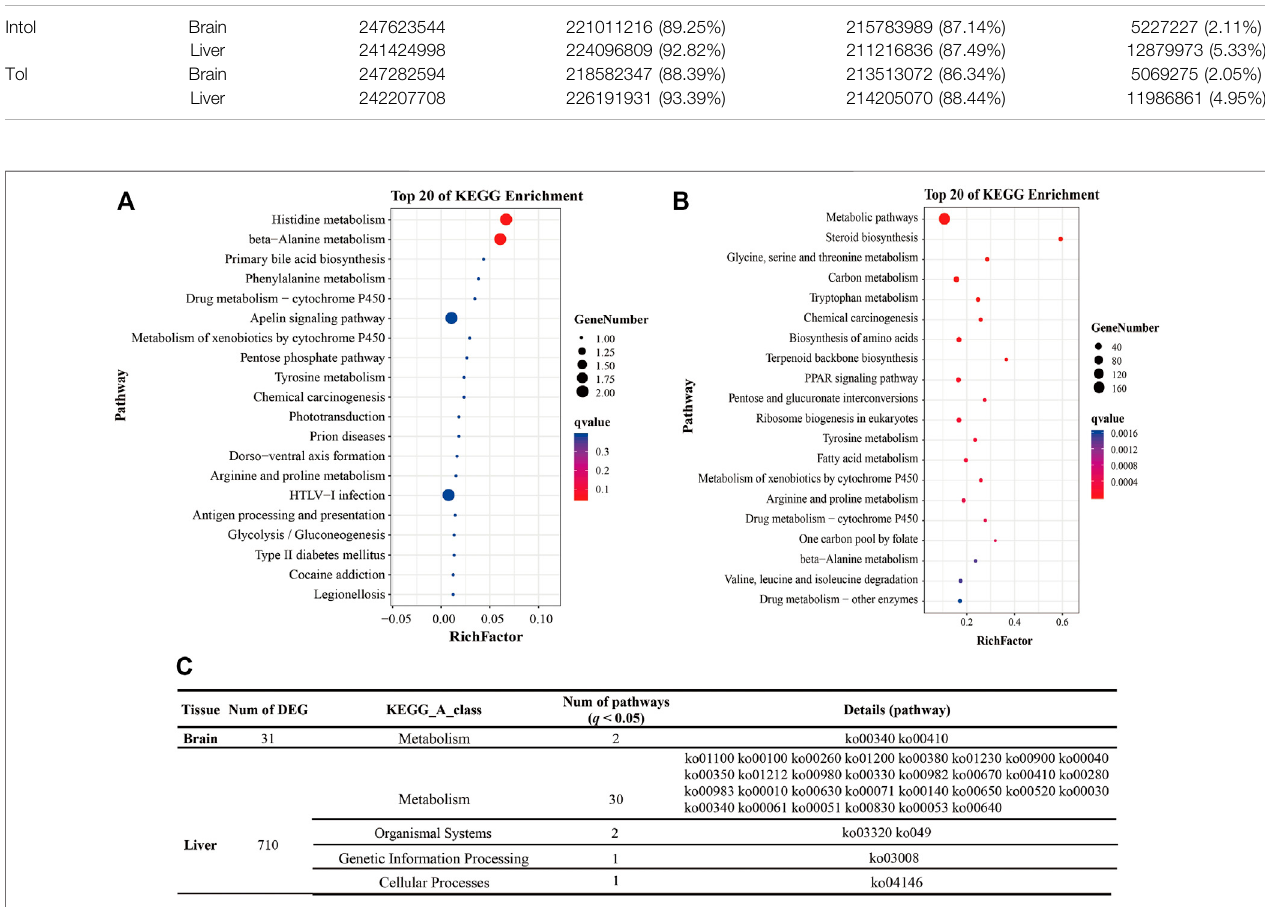
FIGURE 1 | Pathway enrichment analysis of DEGs. Note: (A) The top 20 pathways enriched by DEGs of the brain in the different groups (Intol-vs-Tol). (B) The top 20 pathways enriched by DEGs of the liver in the different groups (Intol-vs-Tol). (C) The table shows the statistical results of pathways with q < 0.05.